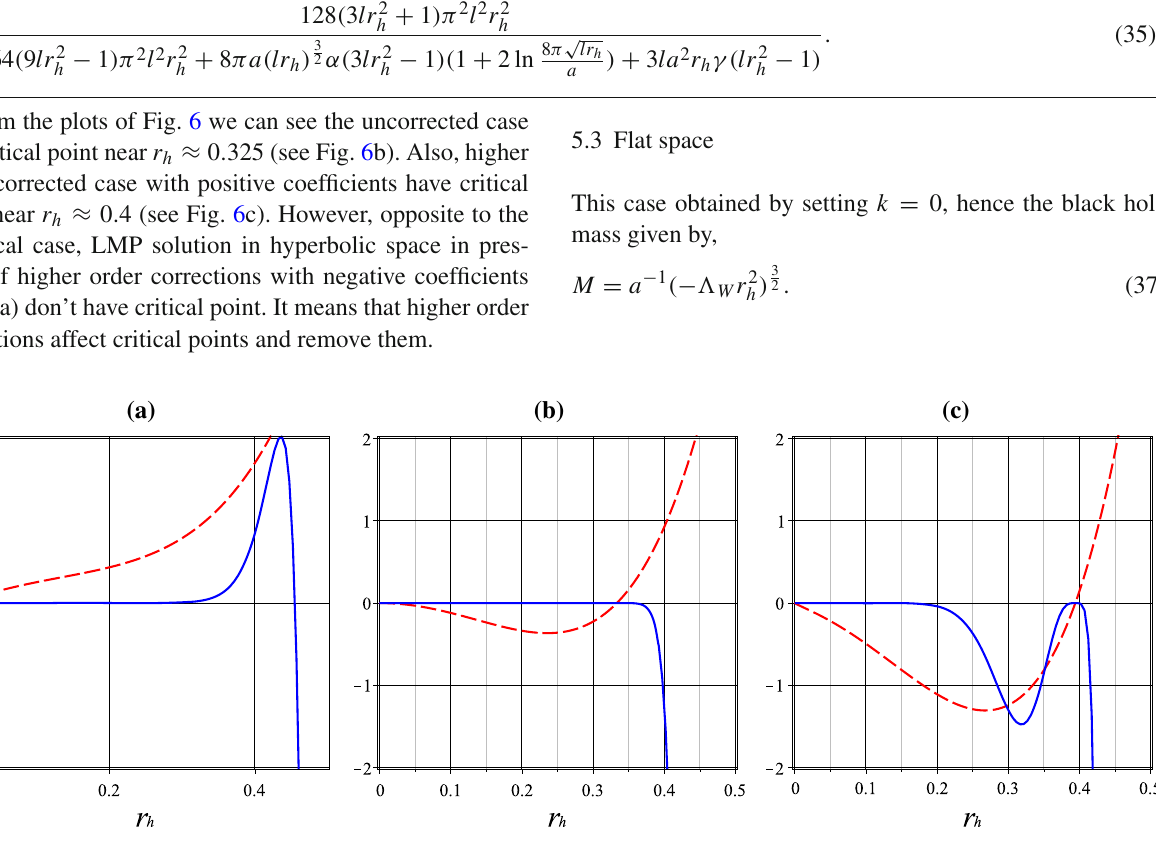
Fig. 6 Critical points of LMP solution in hyperbolic space for l = 1 and a = 10: a α = γ = − 1. b α = γ = 0. c α = γ = 1. Dashed red lines , while solid blue lines represent d 2 P represent dP dV dV